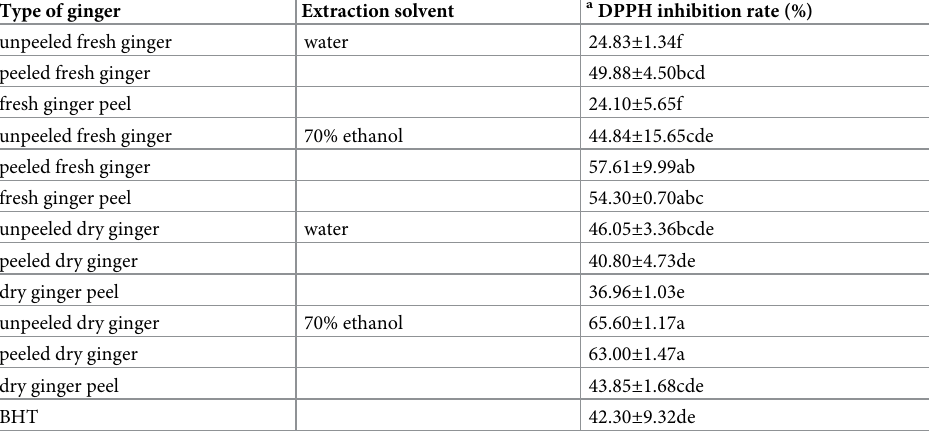
a: Different lowercase letters in the column indicate a significant difference ( p <